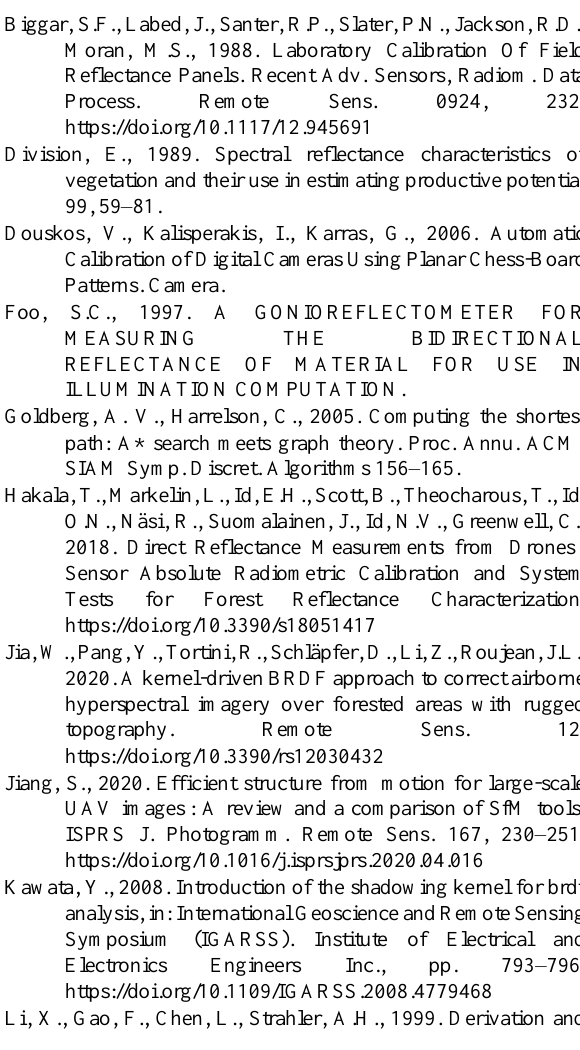
Figure 7 . The reflectance values of the Grass ROI before correction (a), after correction (b), and the statistics CV of reflectance values at different zenith angles (c).